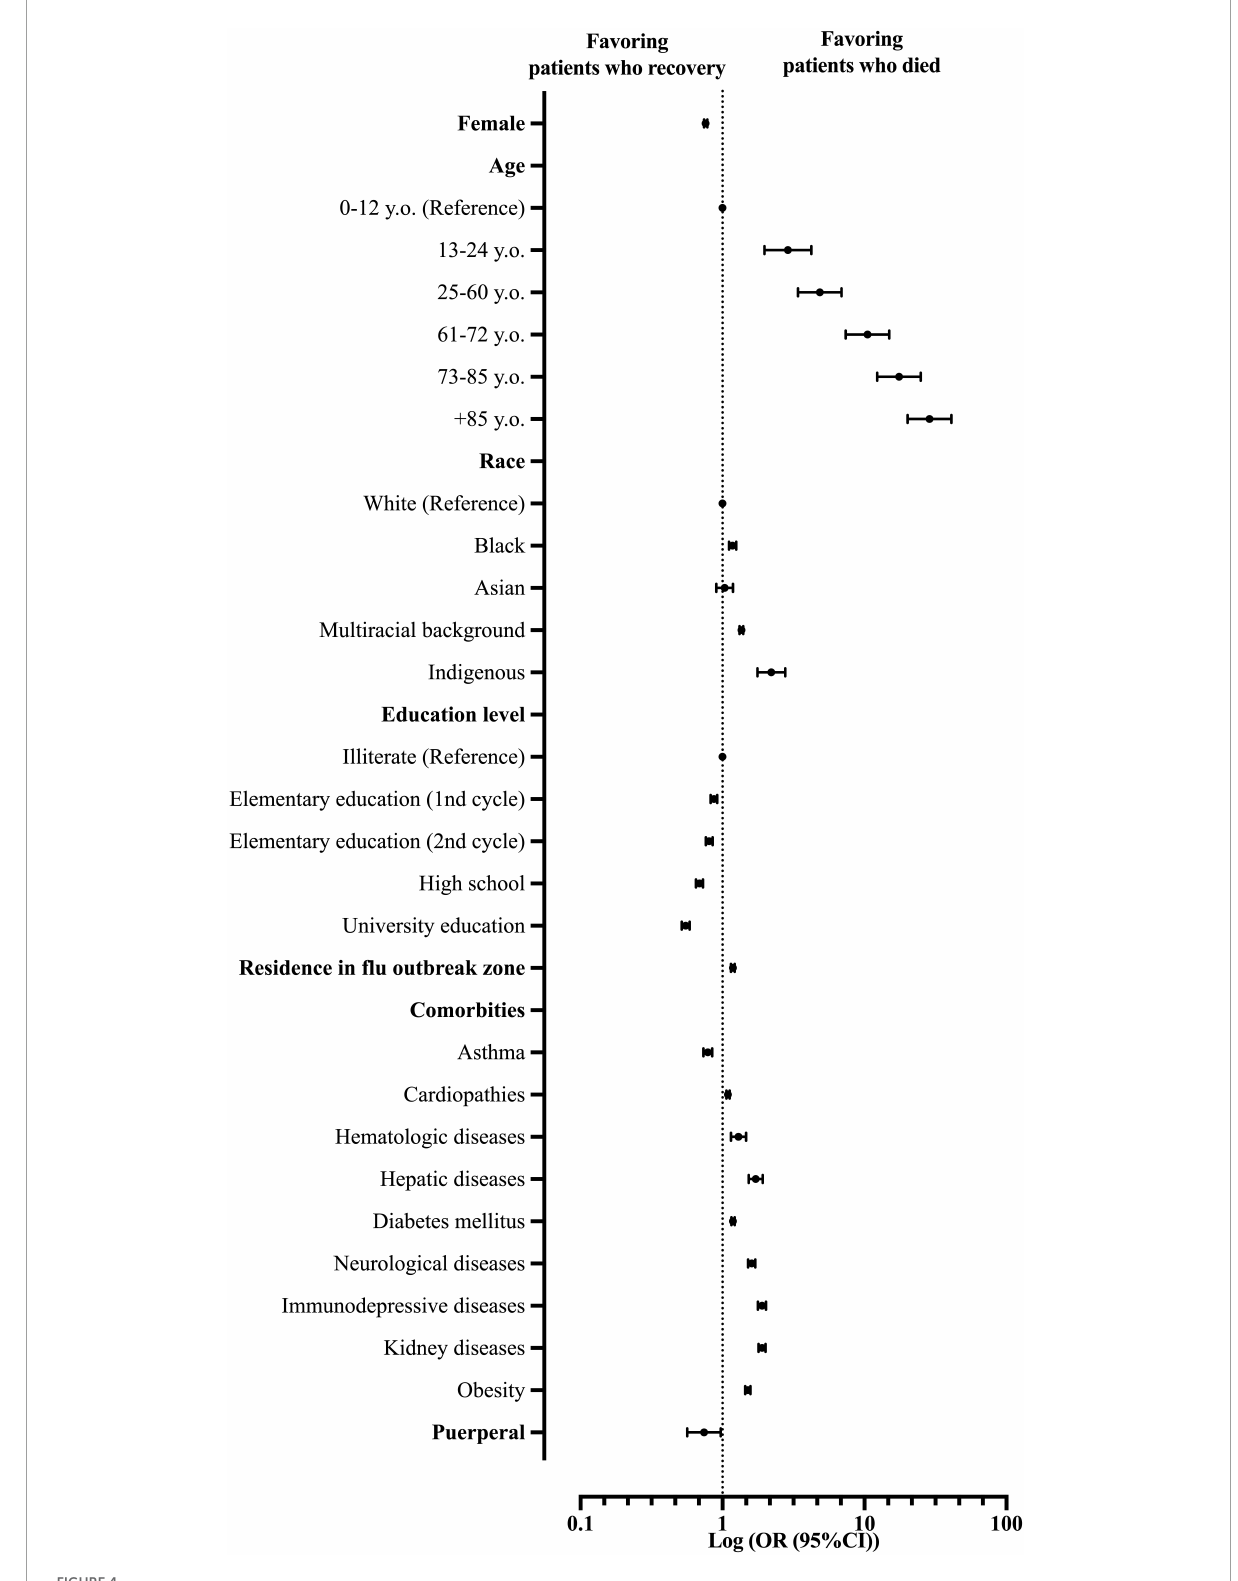
FIGURE4 Multivariate analysis demonstrates the main predictors for death in patients hospitalized with severe acute respiratory syndrome (SARS) due to coronavirus disease (COVID-19) in Brazil. OR, odds ratio; 95% CI, 95% confidence